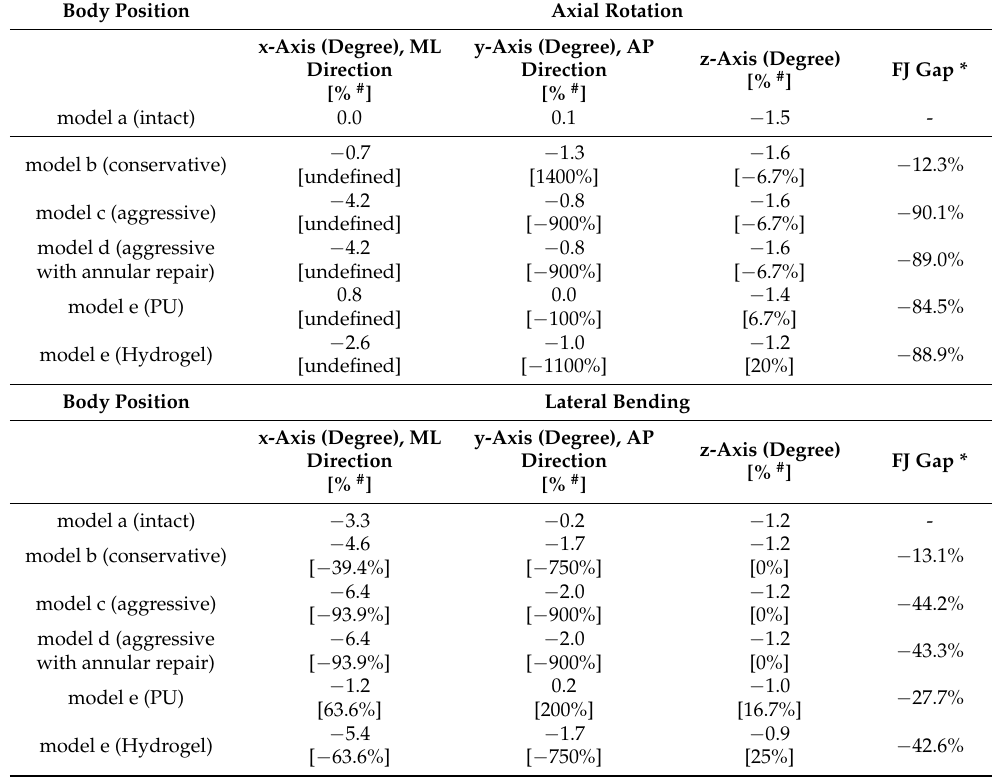
Table 3. Cont. Body